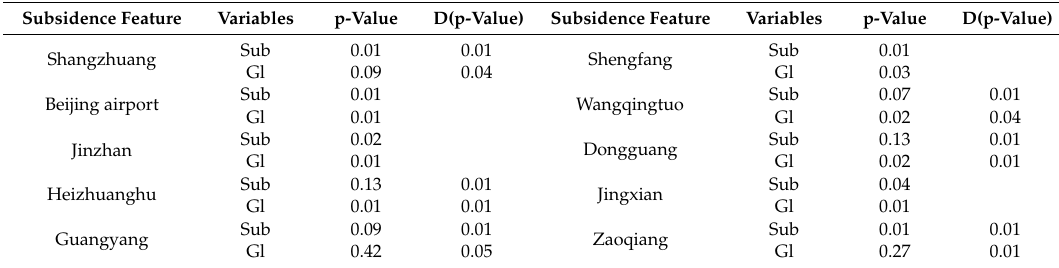
Table 3. The ADF test results of subsidence and groundwater level change in subsidence features from (a) to (j). The sub and Gl in table are subsidence and groundwater level,